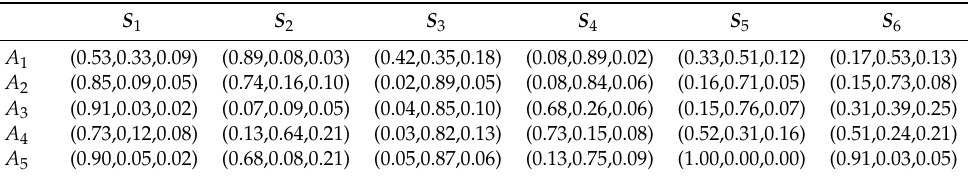
Table 1. The picture fuzzy decision